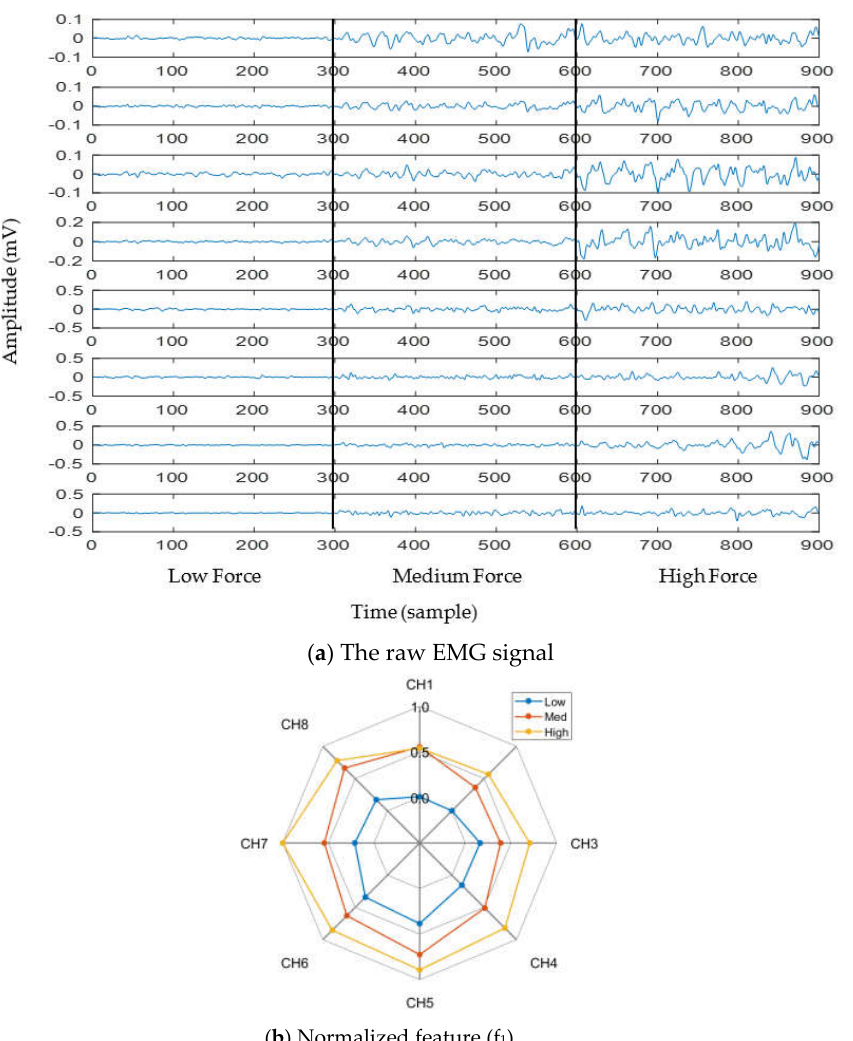
Figure 3. The impact of muscle force variation on a gesture (thumb flexion), where ( a ) presents the raw EMG signal and ( b ) presents normalized feature (f 1